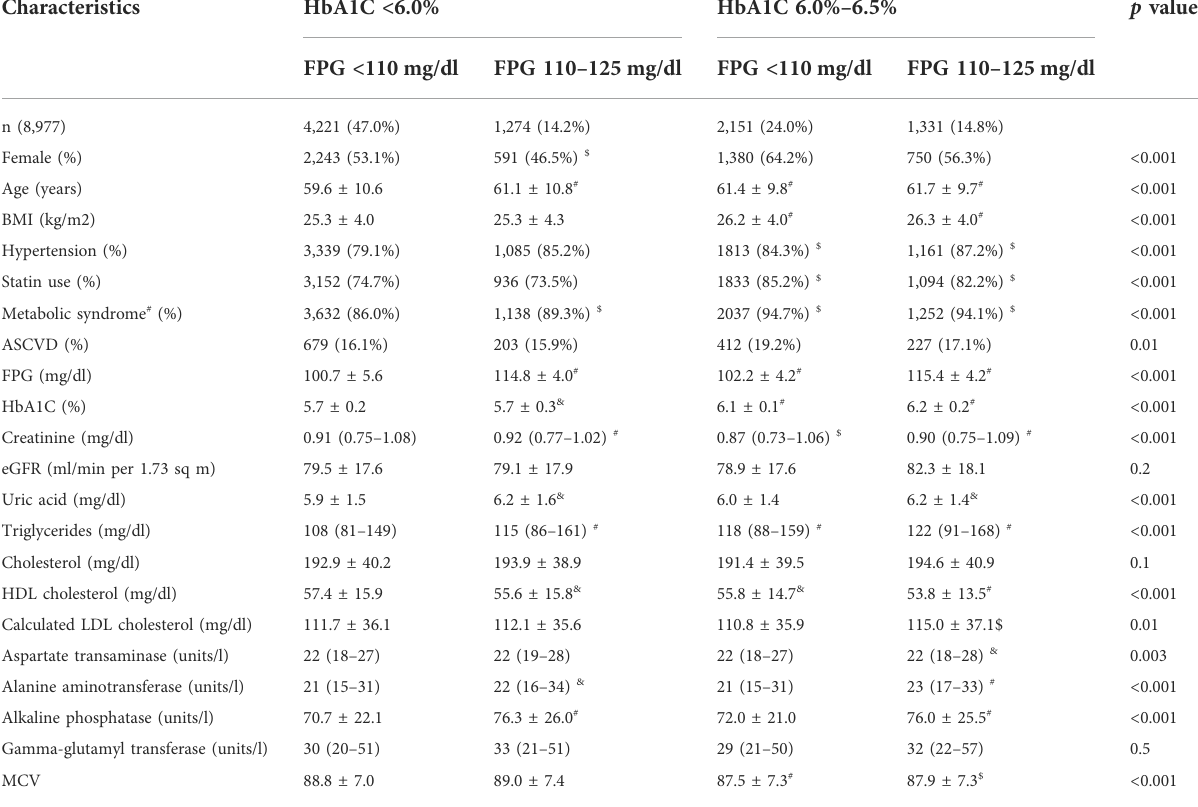
TABLE 1 Comparison of clinical characteristics of high-risk people in the FPG and HbA1c ranges.